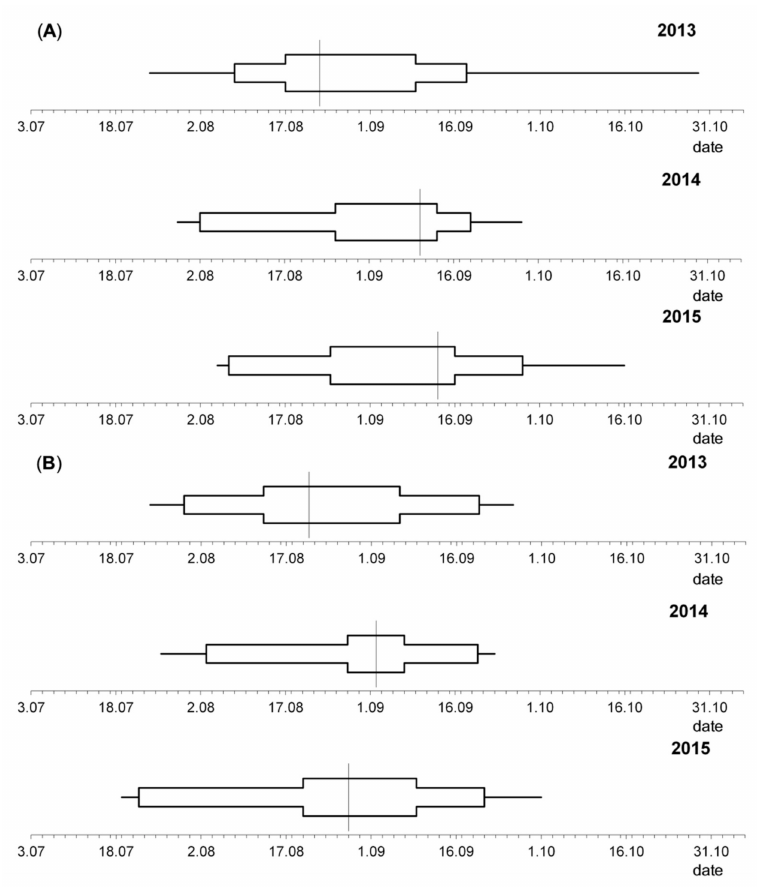
Figure 5. Dynamics of Ambrosia pollen seasons in 2013-2015 ( A ) in Lublin; ( B ) in